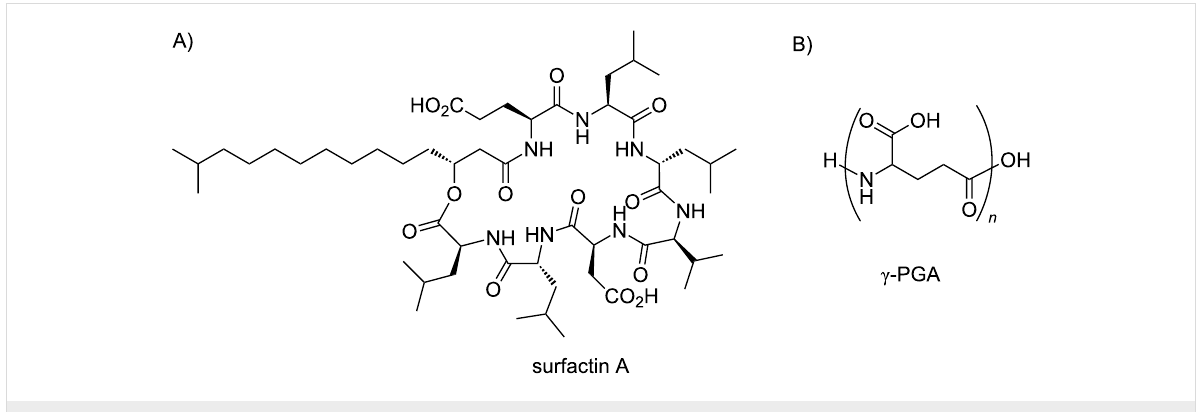
Figure 2: Chemical structures of (A) surfactin A and (B) poly- γ -glutamic